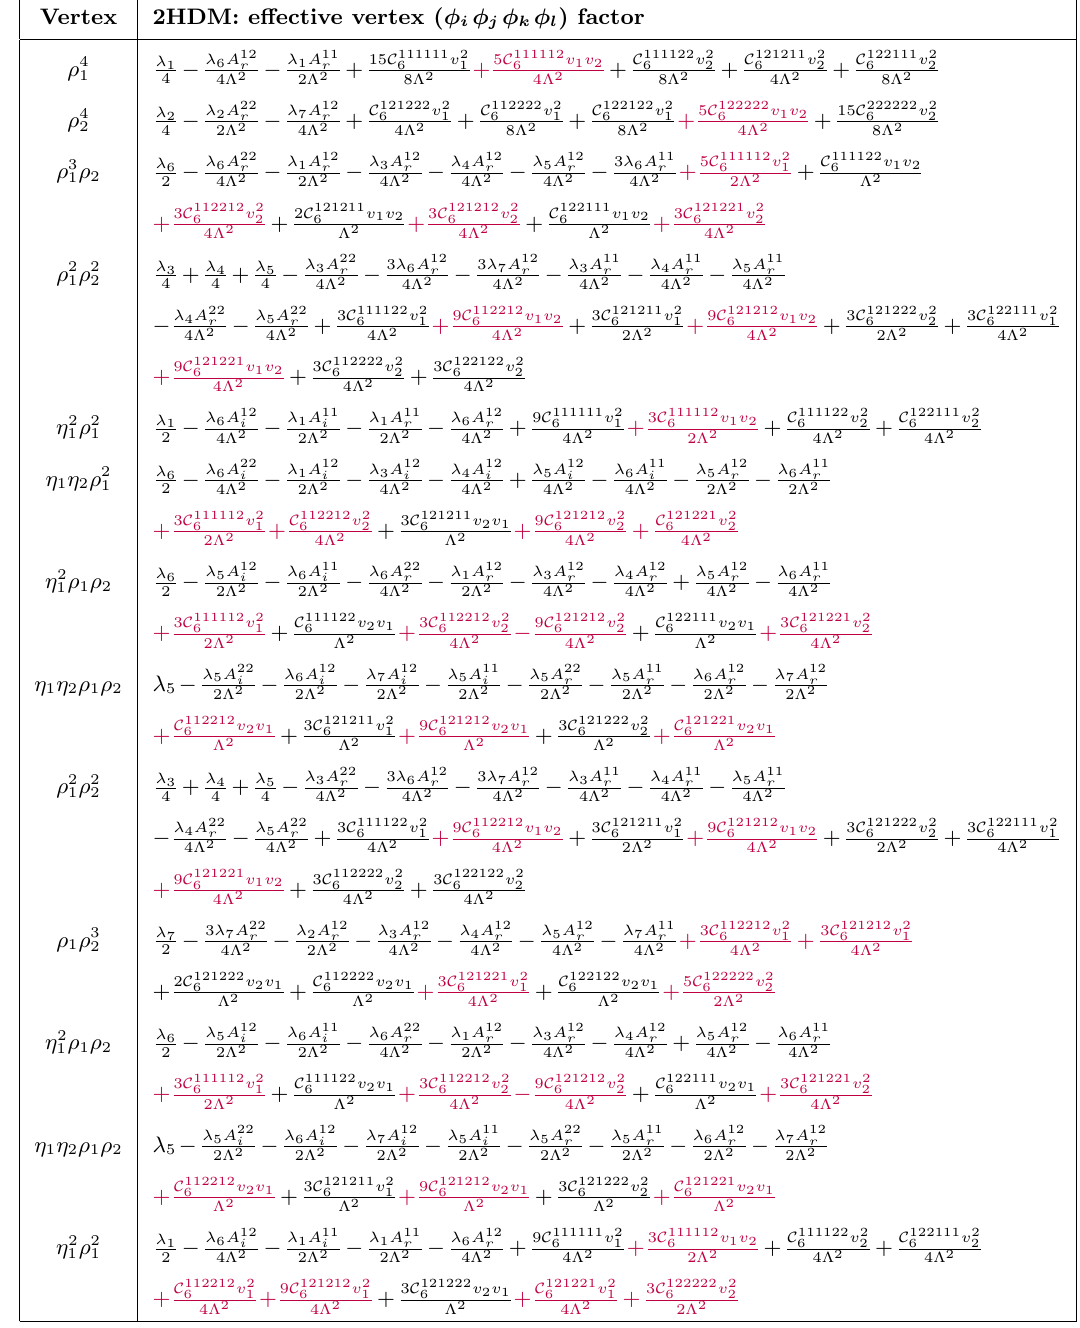
Table 48. 2HDM: scalar four-point vertices in the unphysical basis.